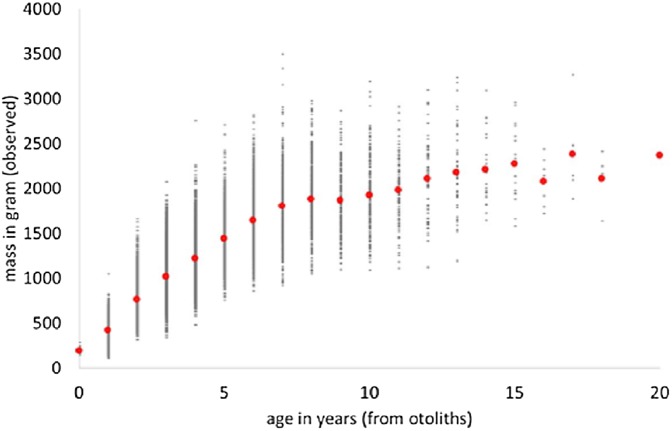
Weight-at-age and average weight (red dots) of male Walleye from Lake Erie.